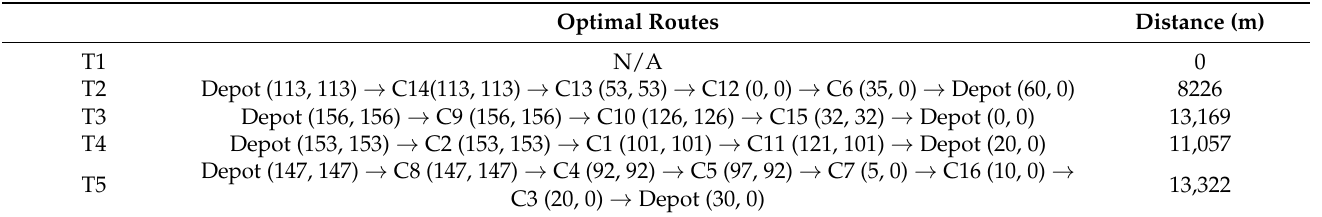
Table 6. Results of solving the LIRP-PP for the pallet delivery and